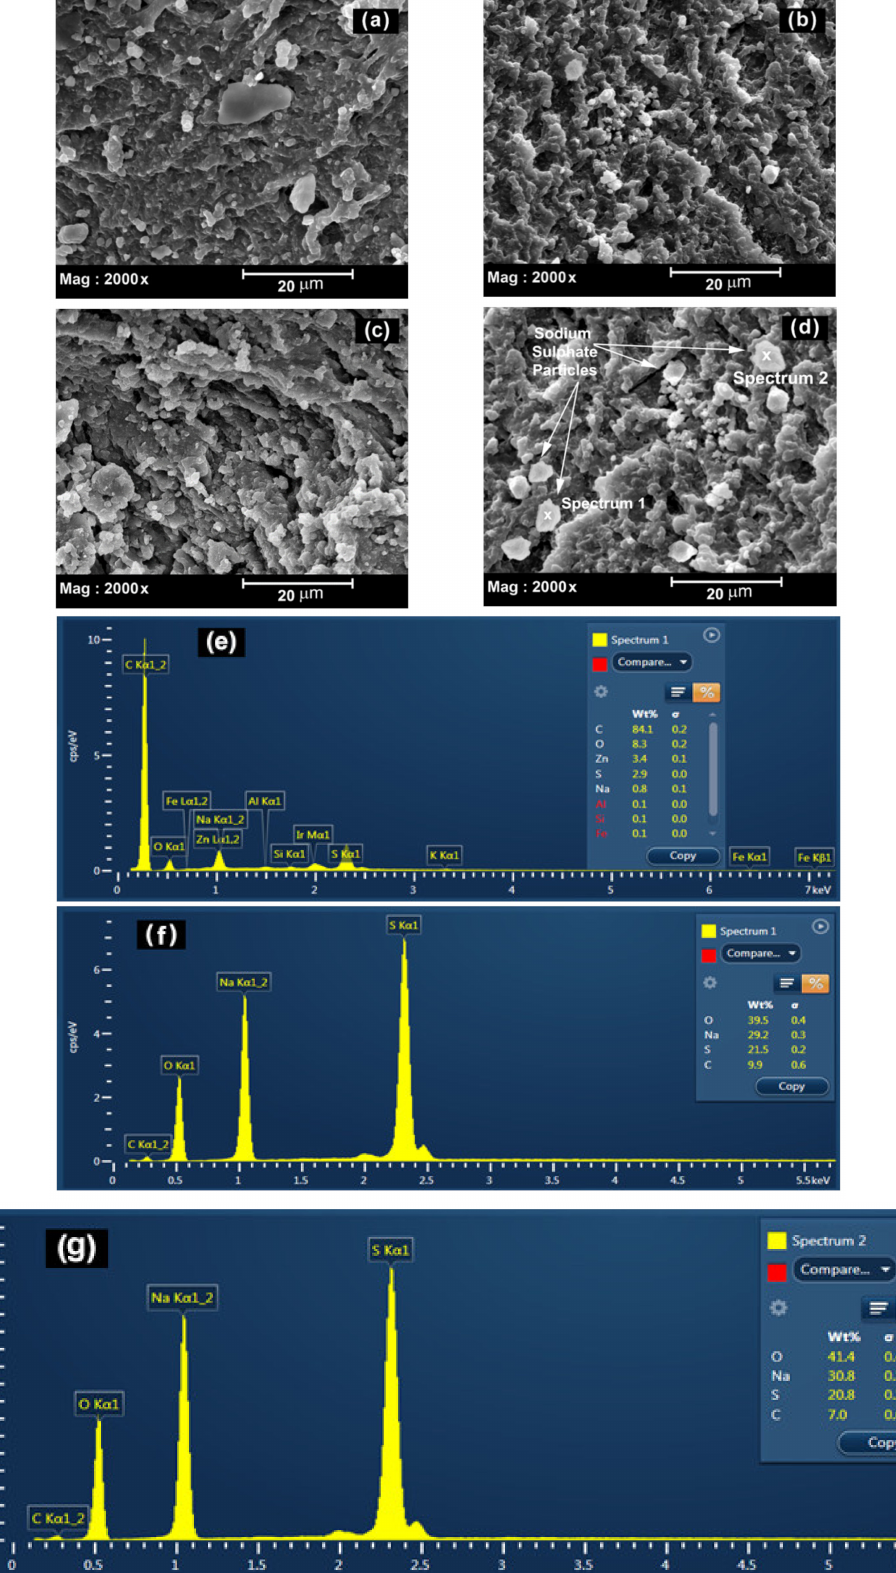
Figure 3. SEM images of ( a – c ) raw rubber, ( d ) rubber soaked in 5% sodium sulphate solution for 2 h, ( e ) EDS analysis of untreated crumb rubber, ( f ) Spectrum 1, and ( g ) Spectrum 2 of the EDS analysis of the rubber particles soaked in 5% sodium sulphate